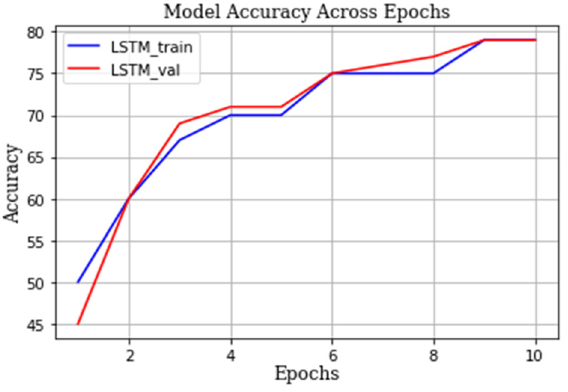
Figure 7. Performance Assessment.